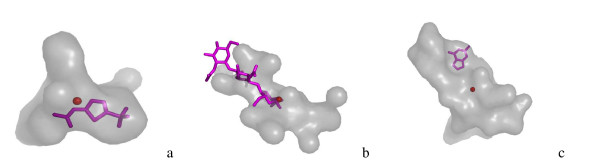
The occupancy of ligands on predicted pocket sites. Grey: the whole pocket sites, Red: mass center of pocket sites and Magenta: ligand. a). Carbonic anhydrase II (2cba), a perfect prediction. b). Acetylchitotriose (1hel) good prediction but only a small part of ligand atoms occupy the pocket sites. c). Purine nucleoside phosphorylase (1ula), the pocket sites cover all atoms of the ligand. The minimal distance is 5.10 Å since ligand is very small and it is not counted as a hit.